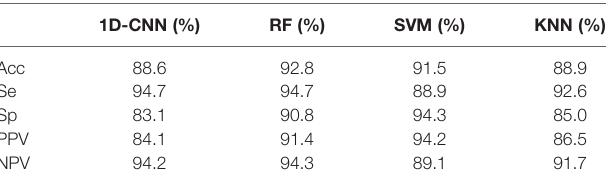
TABLE 3 | Evaluation of diagnostic ef fi ciency of one-dimensional convolutional neural network (1D-CNN), random forest (RF), support vector machine (SVM), and K-nearest neighbor (KNN) classi fi cation models.